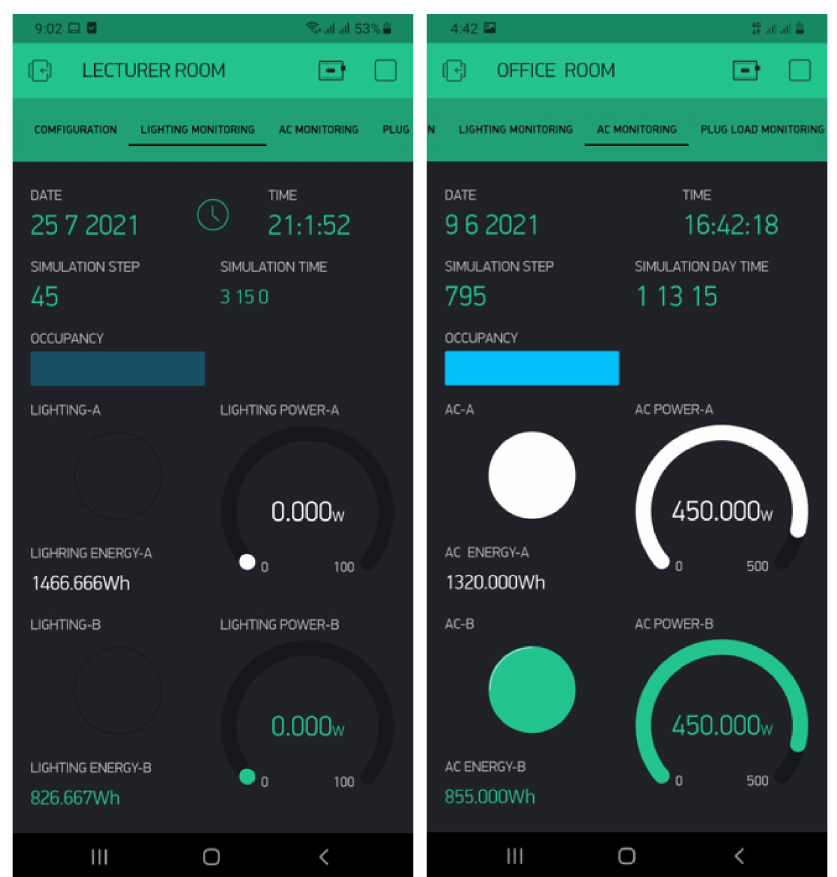
Figure 8. Blynk application for monitoring the